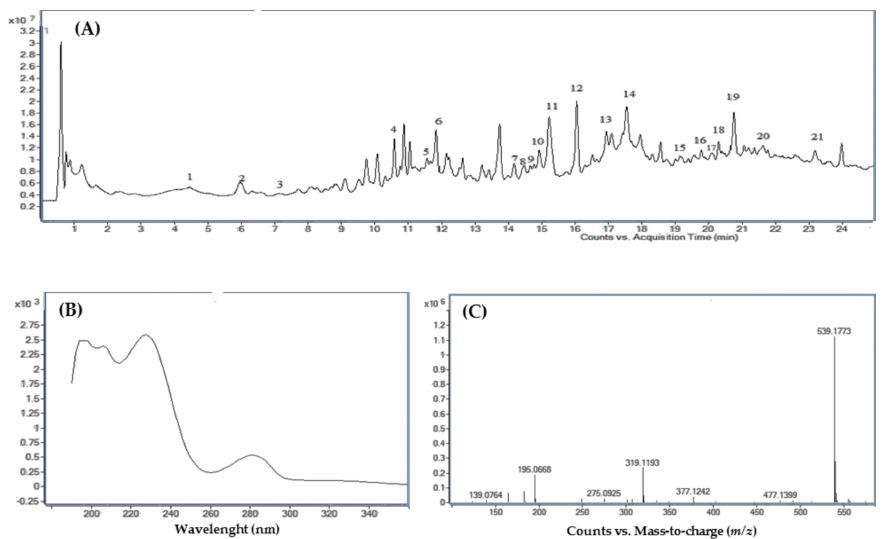
Figure 3. LC–MS Q-TOF analysis of an olive leaf extract. ( A ) Total ion chromatogram (TIC); ( B ) UV–vis, and ( C ) mass spectra of oleuropein ( m / z = 539). Peak numbers in ( A ) are those reported in Table